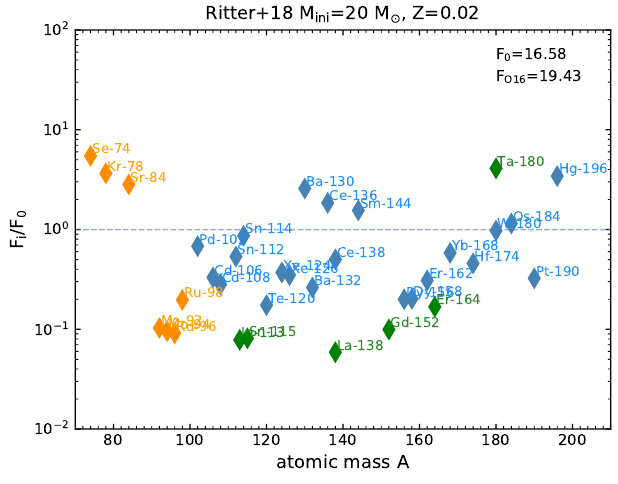
Figure 2. Normalized p –nuclide overproduction factors of the total ejected yields for the model showed in Figure 1. The orange symbols represent the p –nuclei that may have an additional explosive contri- bution, while the green symbols represent the p –nuclei that have also s –, r –process or neutrino-capture